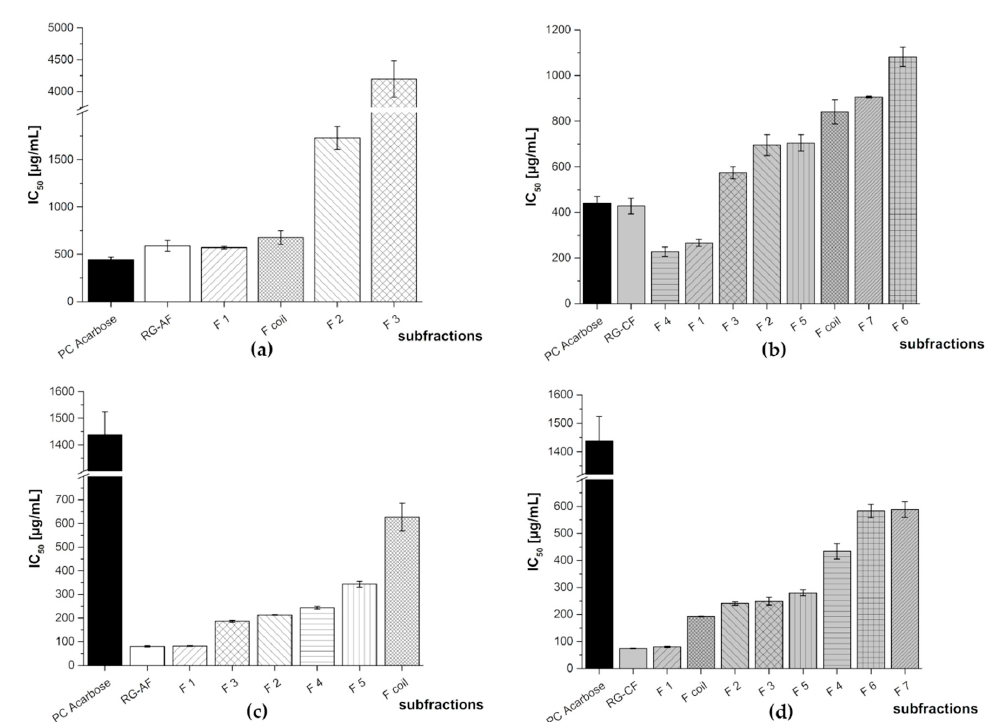
Figure 6. Inhibitory activities (IC 50 values) of the HPCCC subfractions of red grape JC anthocyanin fraction (RG-AF) and red grape JC copigment fraction (RG-CF) in comparison to the positive control (PC) acarbose. Results are presented as means ± SD ( n = 3). ( a ) RG-AF α -amylase assay (F4, F5: N/A), ( b ) RG-CF α -amylase assay, ( c ) RG-AF α -glucosidase assay, and ( d ) RG-CF α -glucosidase assay. N/A = not available. Table 3. Inhibitory activities (IC 50 values) of the HPCCC subfractions of red grape JC anthocyanin (RG-AF) and copigment fraction (RG-CF). Results are presented as means ± SD ( n = 3). N / A = not